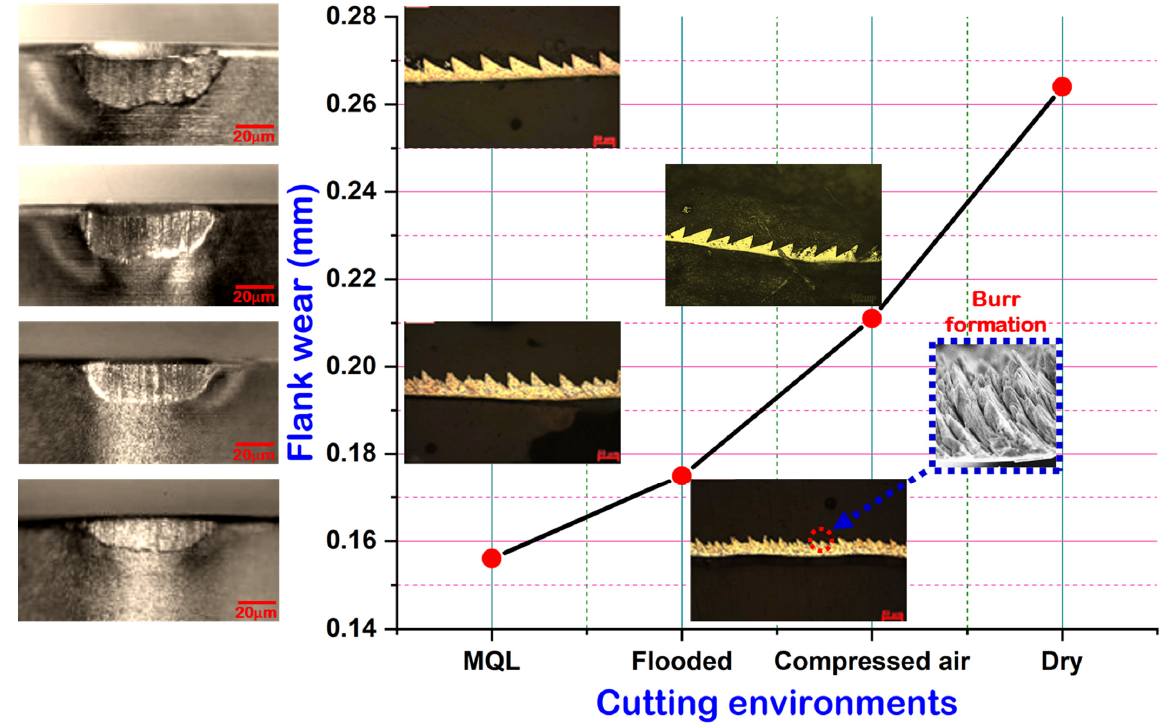
Figure 9. Effect of serrated saw-tooth chip on tool’s flank wear at v = 111 m/min; f = 0.20 mm/rev.